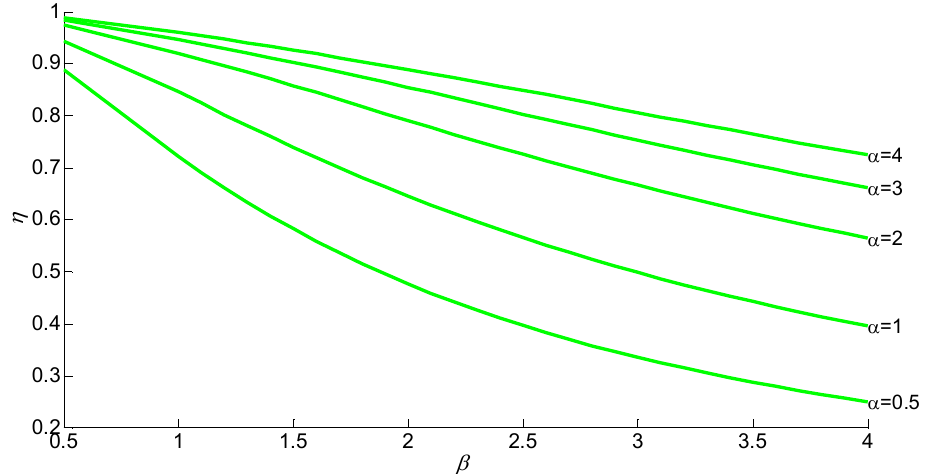
Figure 6. Trend of the ratio between the downstream and the upstream flood peak discharge ( η ) as a function of α and β .